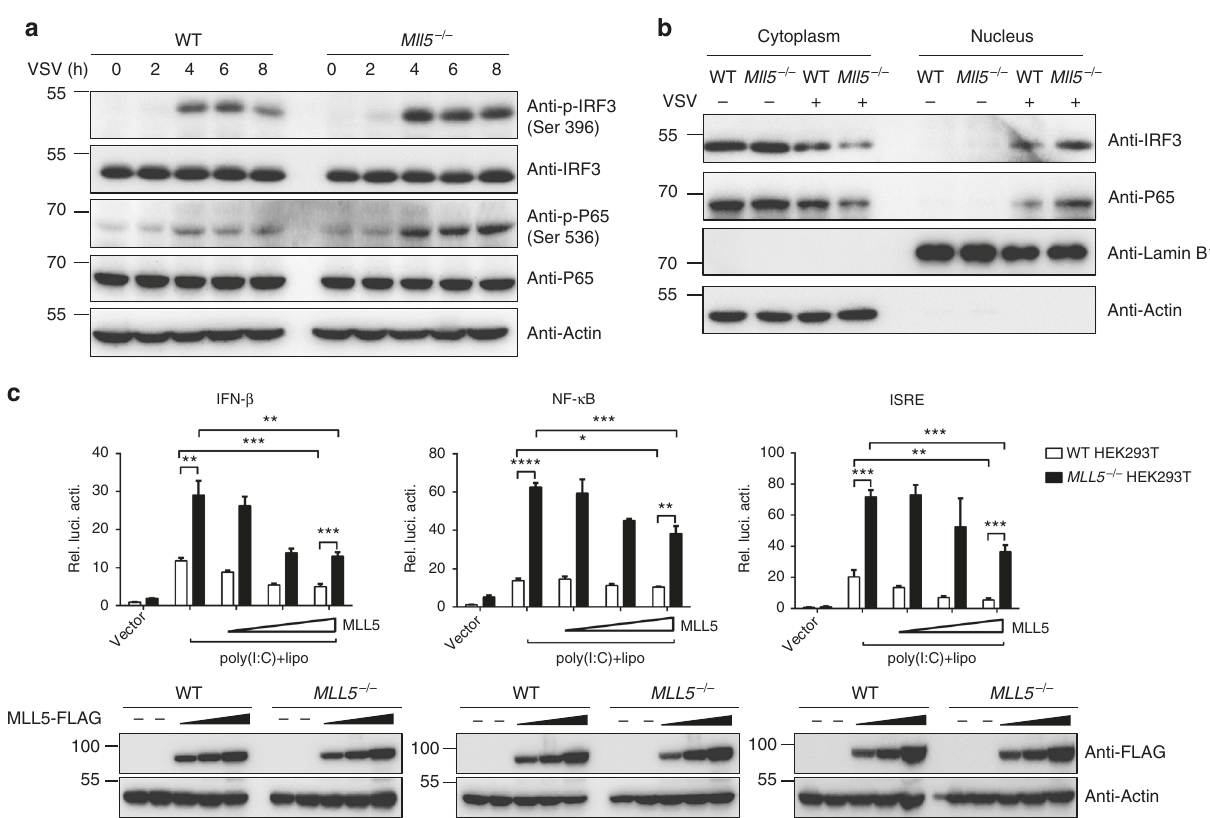
Fig. 2 MLL5 suppresses RLR-mediated immune signaling. a Immunoblot analysis of phosphorylated (p-) IRF3 and P65 in WT and Mll5 − / − MEFs upon infection with VSV-GFP (MOI:1). Actin served as a loading control. b Immunoblot analysis of IRF3 and P65 protein in nuclear and cytoplasmic fractions in WT and Mll5 − / − MEFs infected with VSV-GFP (MOI:1). Actin served as a cytoplasmic control. Lamin B1 served as a nuclear protein control. c WT and MLL5 − / − HEK293T cells were transiently transfected with indicated reporter plasmids (200 ng) along with MLL5-expressing plasmids (0, 100, 300, and 600 ng). After 24 h, a luciferase assay was performed with stimulation of intracellular poly(I:C) (1 μ g/ml) for 16 h. Results were presented relative to the luciferase activity in control cells (transfected with luciferase reporter and empty vector without stimulation of intracellular poly(I:C)). Immunoblot analysis of MLL5-FLAG are shown below. Actin served as a loading control. Data were representative of three independent experiments with similar results ( a , b ) or were from three independent experiments ( c ), and were analyzed by Student ’ s t -test (two-tailed) and were presented as mean ± SD (* p < 0.05,** p < 0.01, *** p < 0.001, **** p <